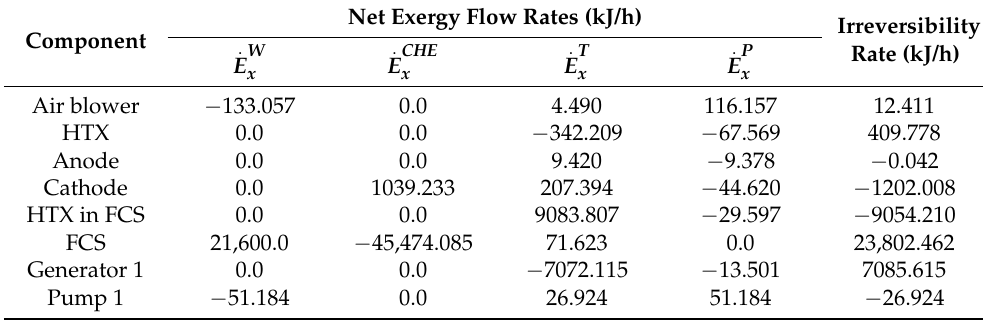
Table 2. Exergy balance for each component in hydrogen-fueled 5-kW PEMFC.